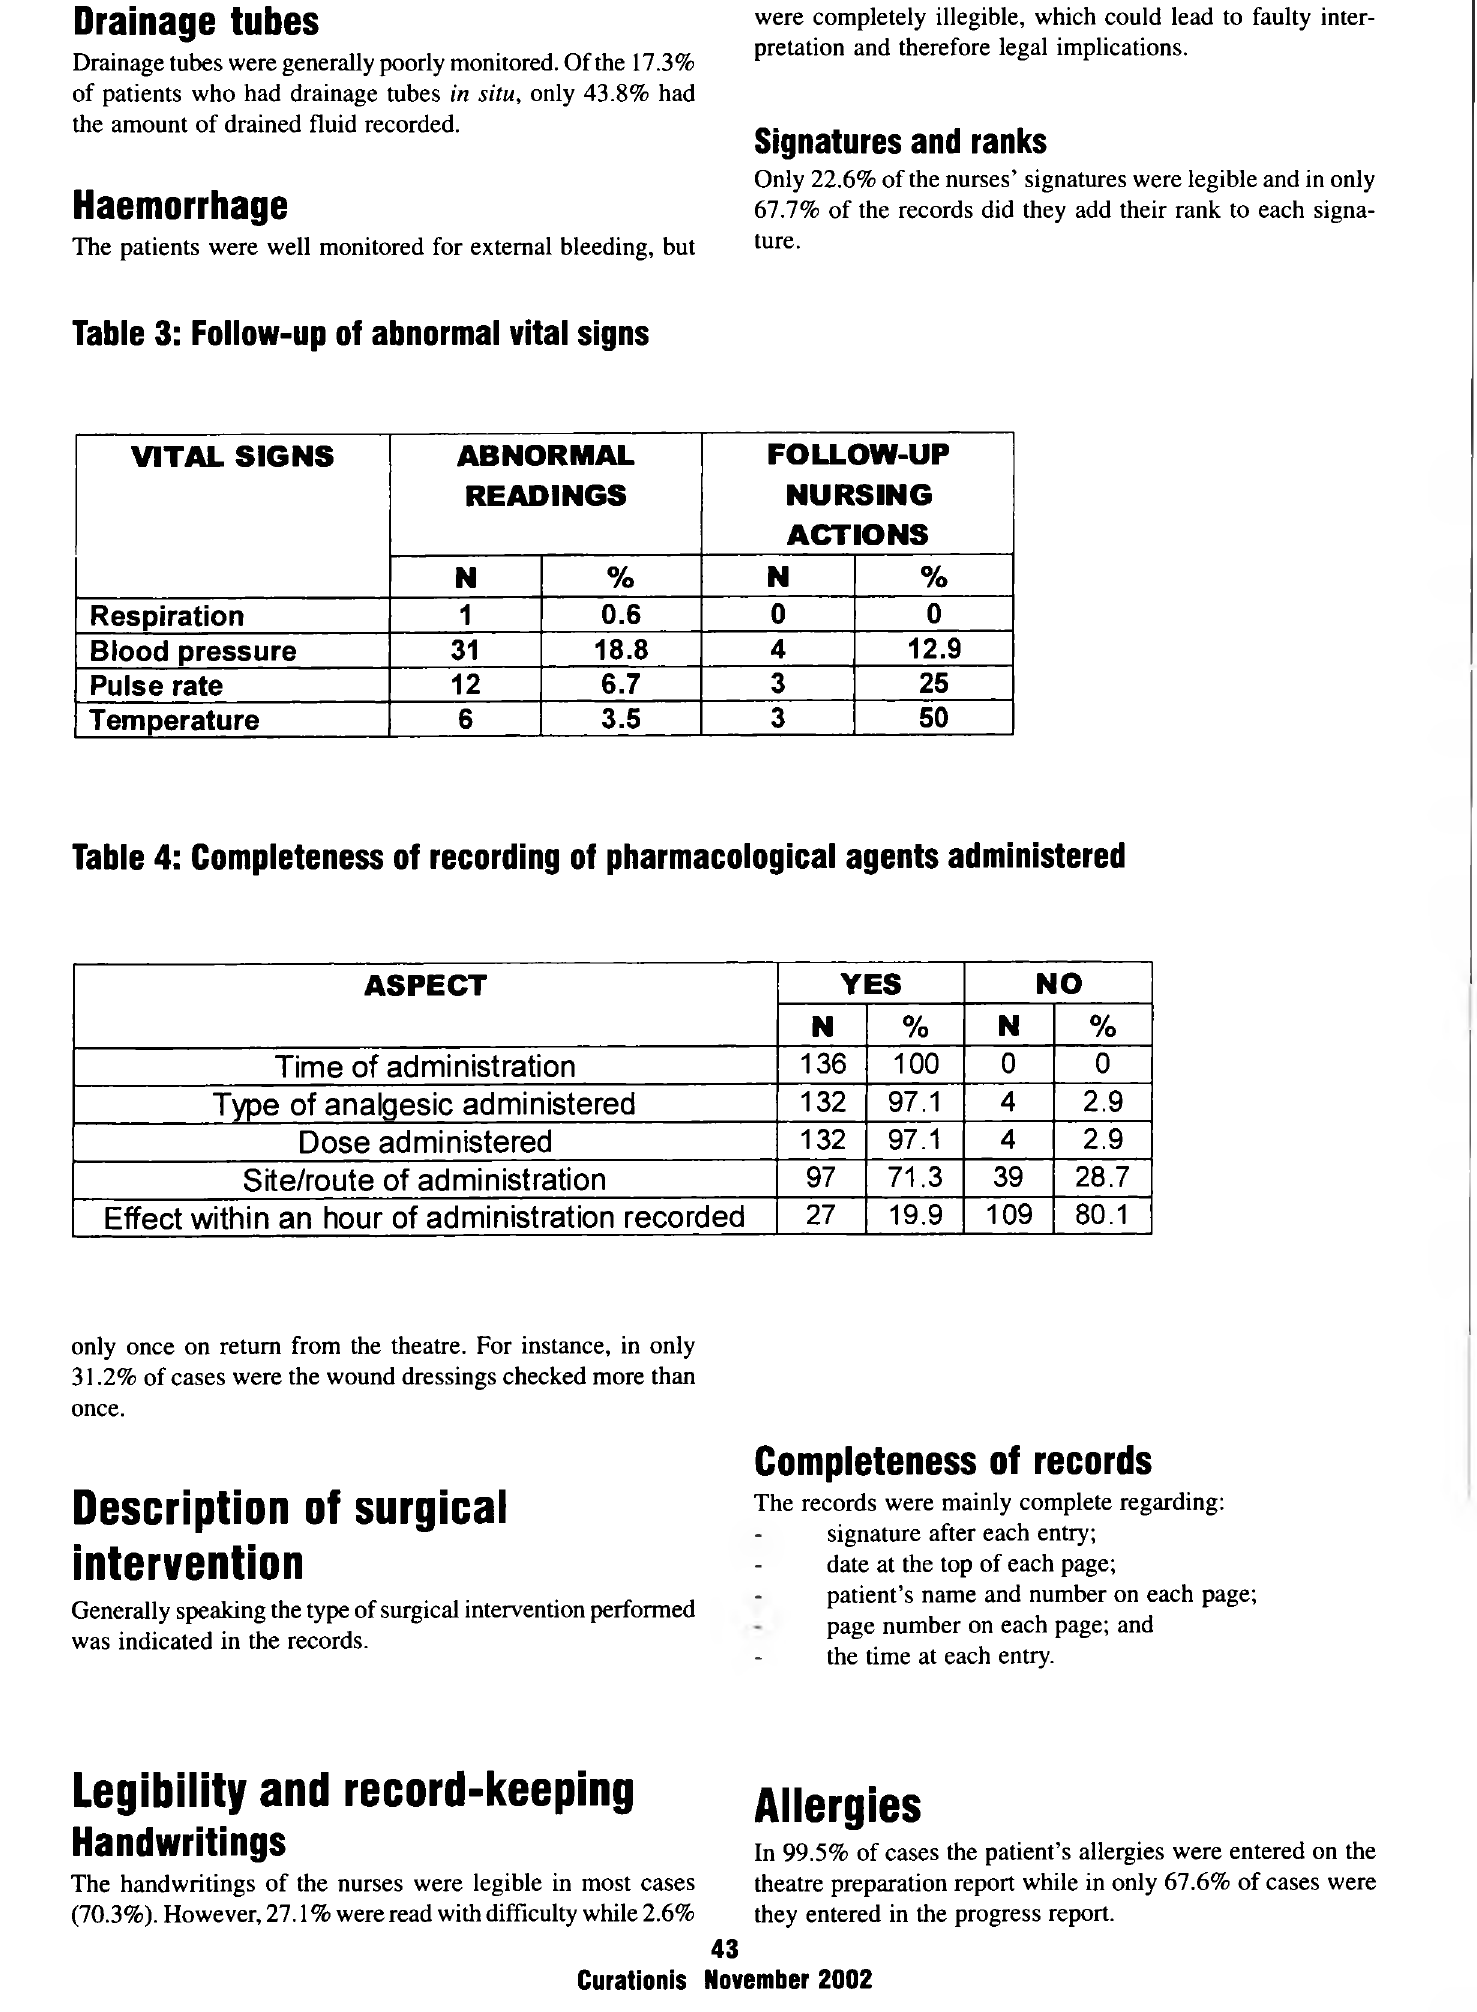
Table 3: Follow-up of abnormal vital signs